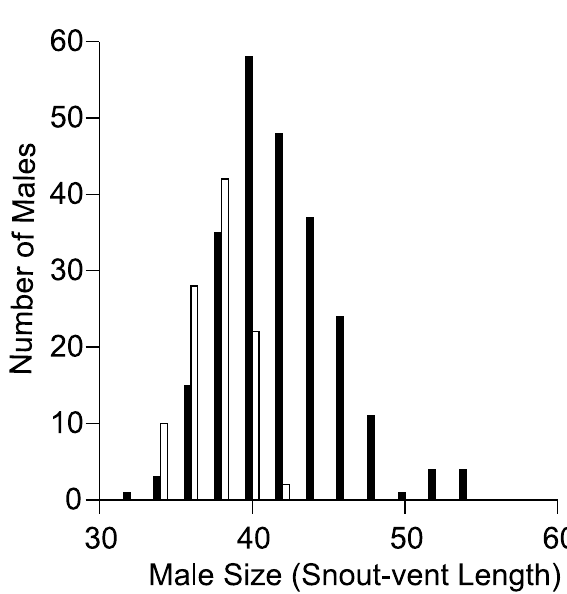
Fig. 4 – Variation in size of adult male Leptodactylus fuscus . Black bars indicate data from localities throughout the geographic range with the exception of adult males from a single locality (Porto Velho, Brazil) indicated by the white